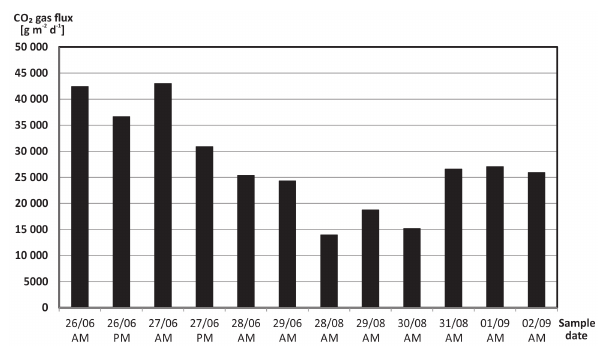
Figure 4. Variations in the CO 2 gas flux at the drill site of HJB-1 measured in